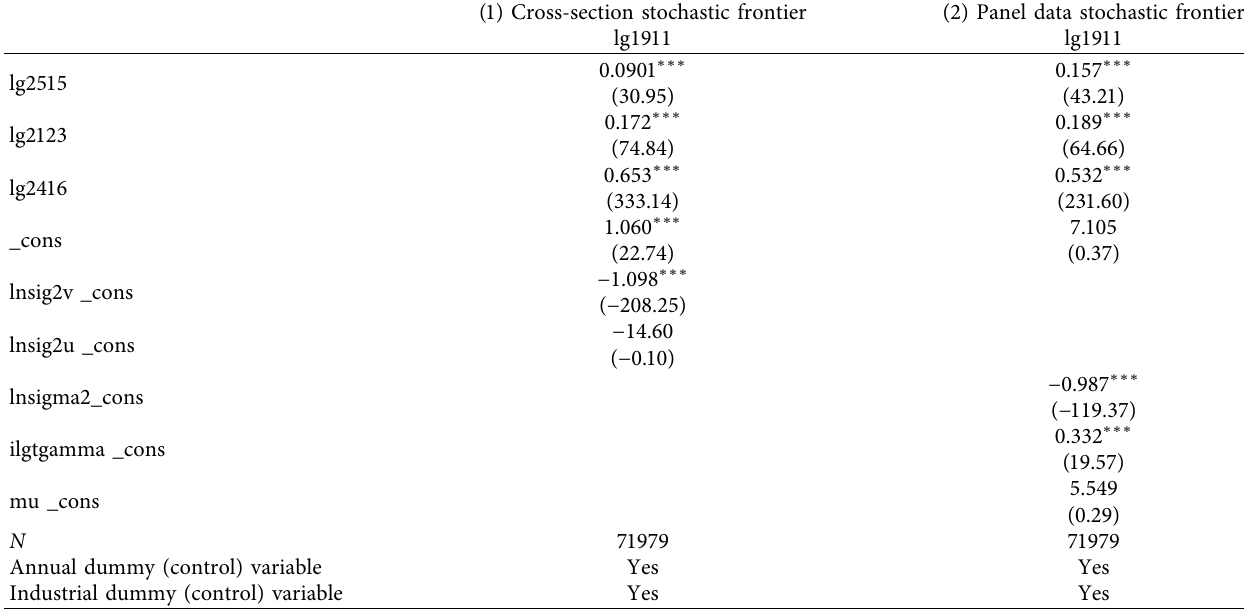
Table 5: Estimations of SFA parameters for the 17